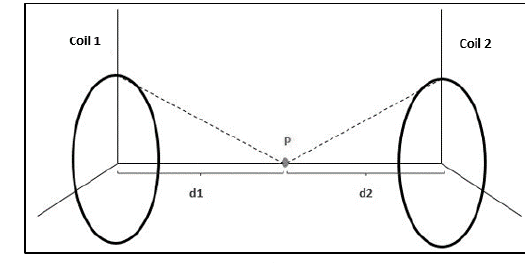
Figure 3. ( a ) The EUT chamber where the cells were placed; ( b ) NIH/3T3 mouse fibroblast cell line cells inside the EUT chamber.